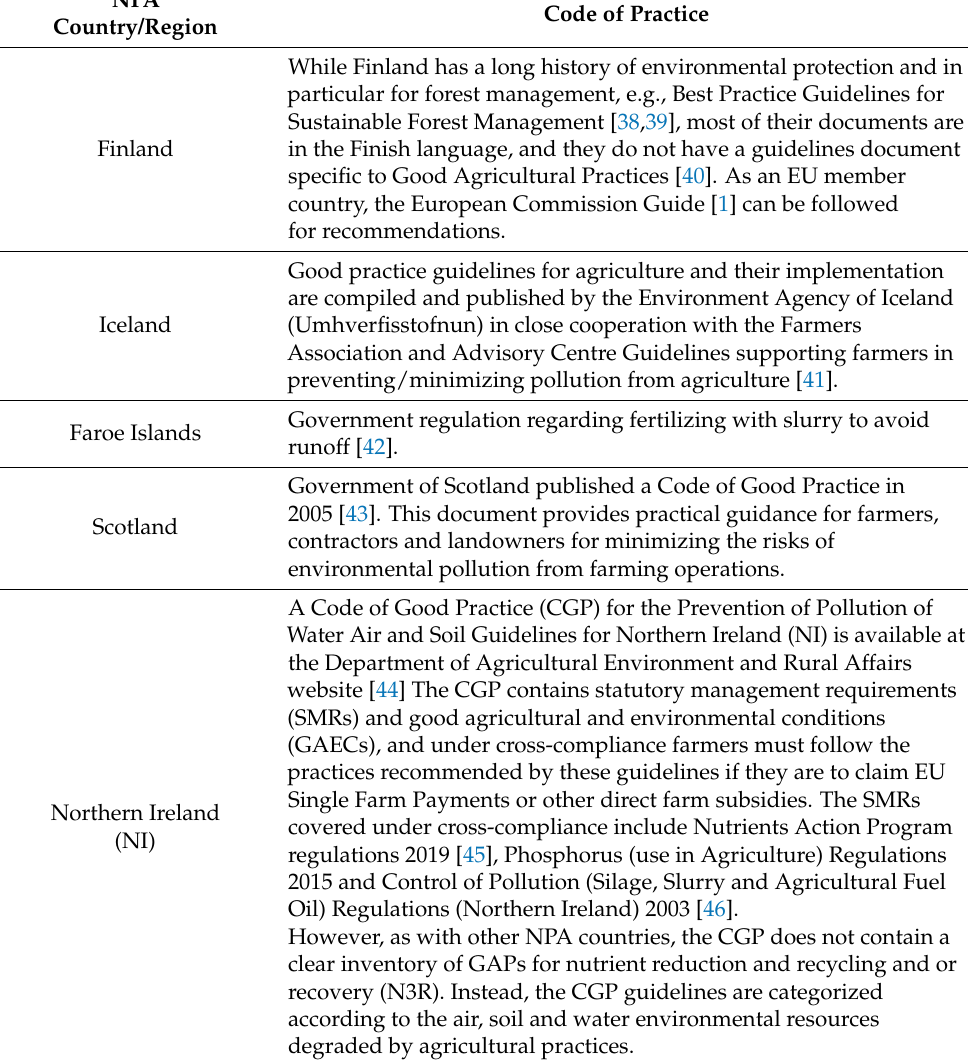
Table 2. NPA country/region code of practice for the prevention of environmental pollution from agricultural